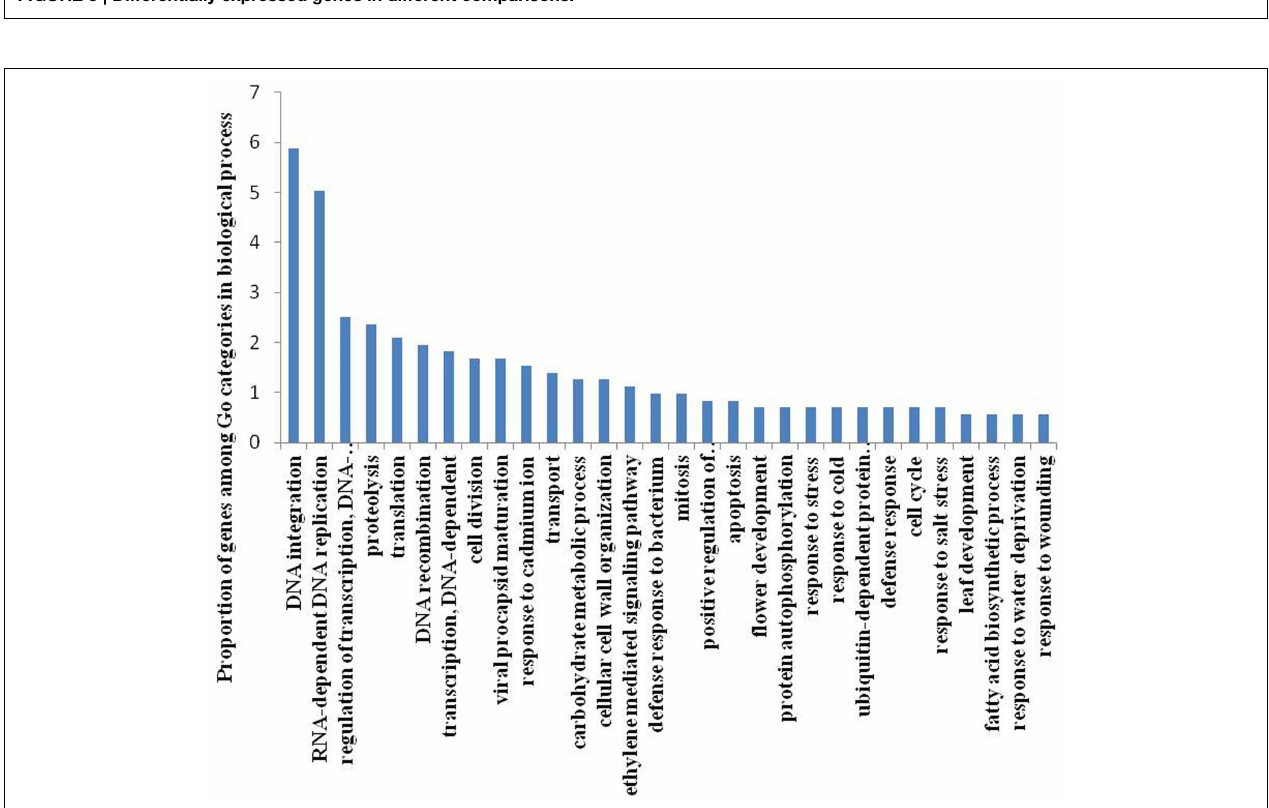
FIGURE 4 | Gene classification based on gene ontology (GO) for differentially expressed genes in Metasequoia in CK4 vs. TR4 comparison in biological processes. The frequency of GO